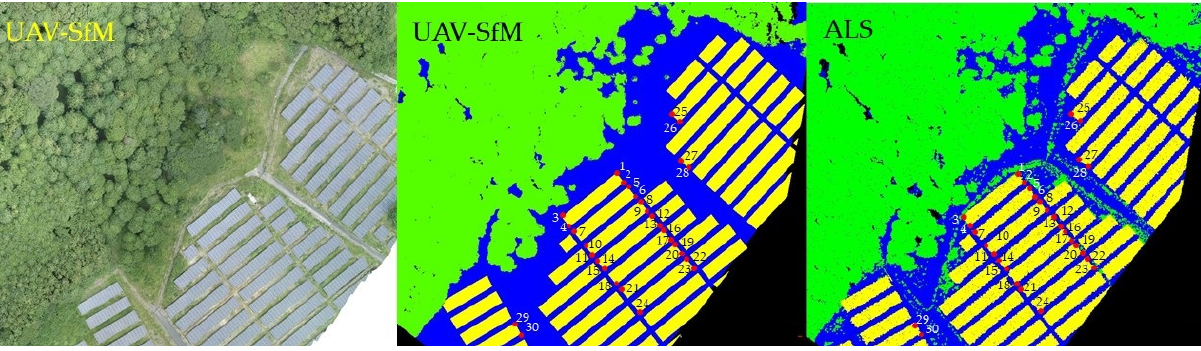
Figure 5. An illustration of independent check points for registration performance evaluation of the UAV-SfM-generated point cloud data. The left image shows the RGB-based orthophoto where the solar panels are next to the Kameyama forest. The center image displays the UAV-SfM-BICPPC data overlaid with check points, the red points, on the corners of some solar panels. The right image demonstrates the ALS point cloud data with corresponding check points on the corners of the solar panels in the center image. Based on the point cloud classes (blue: ground, yellow: solar panel, and green: vegetation), the corner points can be visually recognized and selected as check points for registration performance evaluation. Table 3. Summary of accuracy evaluation of the registered UAV-SfM point cloud dataset (BICPPC). Bias